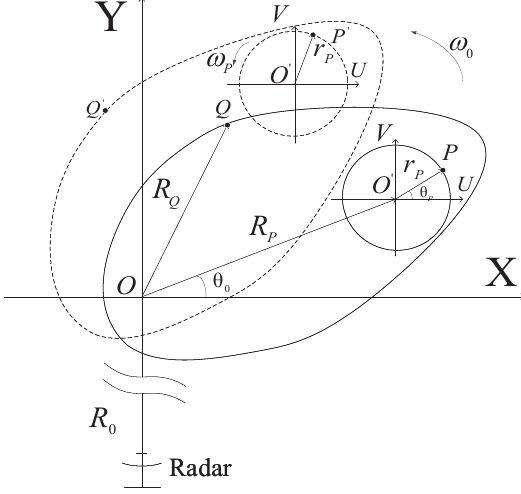
Figure 1. The inverse synthetic aperture radar (ISAR) imaging geometry for a micromotion target. To obtain high range-resolution, ISAR imaging system usually transmits linear frequency-modulated (LFM) waveform. After the preprocessing of demodulation and